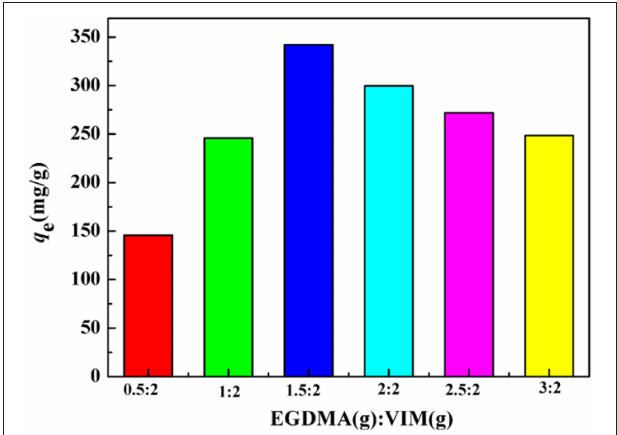
FIGURE 5 | The effect of EGDMA/VIM ratio on adsorption capacity. Adsorption experiments: C 0 : 300 mg/L; sample dose: 20mg/25mL; pH: 5.5; temperature: 30 ◦ C; equilibrium time: 120min.